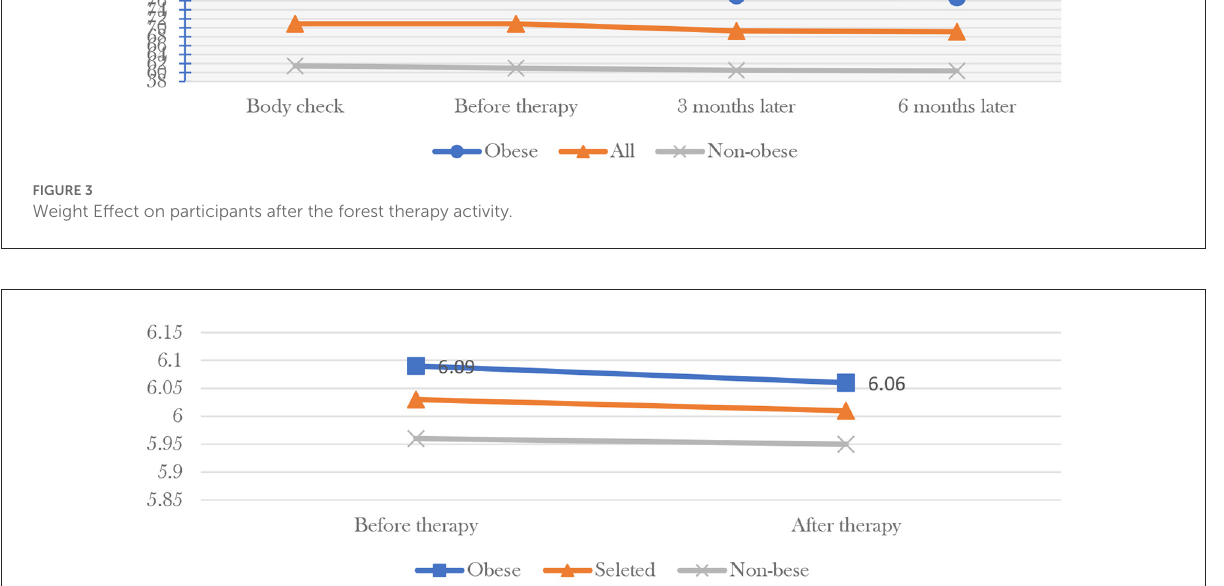
FIGURE4 HbA1c value change of selected participants at four pilot bases. * HbA1c is a term commonly used in relation to diabetes. The term HbA1c refers to glycated hemoglobin. HbA1c is a product of glucose bound to hemoglobin in red blood cells. To a certain extent, the higher the blood glucose, the longer the duration, the higher the value, which can reflect the average blood glucose level in the past 2–3 months and has been used as the gold standard to evaluate the long-term blood glucose control in clinical practice. The normal reference value of the standard HbA1c detection method is 4–6%. Generally, diabetes requires HbA1c value below 7%, and > 7% means an increased risk of diabetic complications. It develops when hemoglobin, a protein within red blood cells that carries oxygen throughout the body, joins with glucose in the blood, becoming “glycated”. In Japan, 6% proposed by the Japanese Diabetes Society in 2013 is generally used as the baseline point of treatment, and the goal is to keep the blood glucose value below 6% when people with diabetes receive relevant treatment. When the blood glucose level is between 6 and 7%, it means that attention should be paid to whether there are complications during treatment. When the blood glucose level is between 7 and 8%, it means that the condition of diabetes has become more